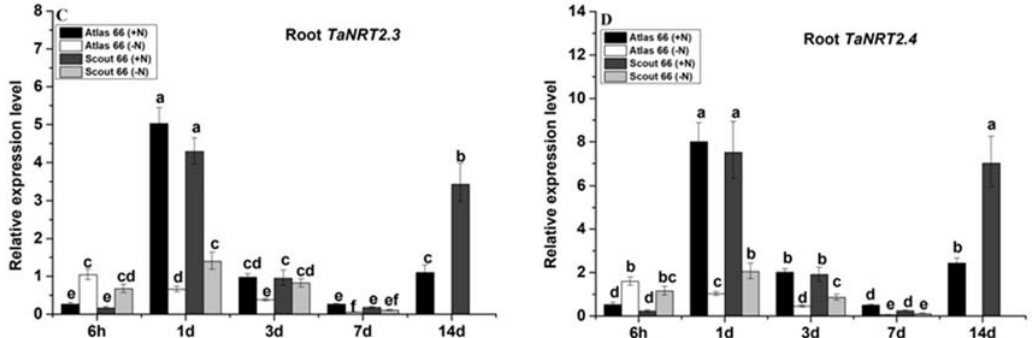
Figure 6. The relative expression level of four targeted genes, TaNAR2.1 ( A ), TaNRT2.1 ( B ), TaNRT2.3 , ( C ), TaNRT2.4 ( D ) in roots of Atlas 66 and Scout 66 grown in N sufficient (2 mM) and deficient (50 μ M) conditions from 6 h to 14 d time points from both N levels. Bars represent the mean ± SD ( n = 3). Different small letters indicate statistically significant differences based on LSD tests ( p ≤ 0.05) among the treatments and cultivars.